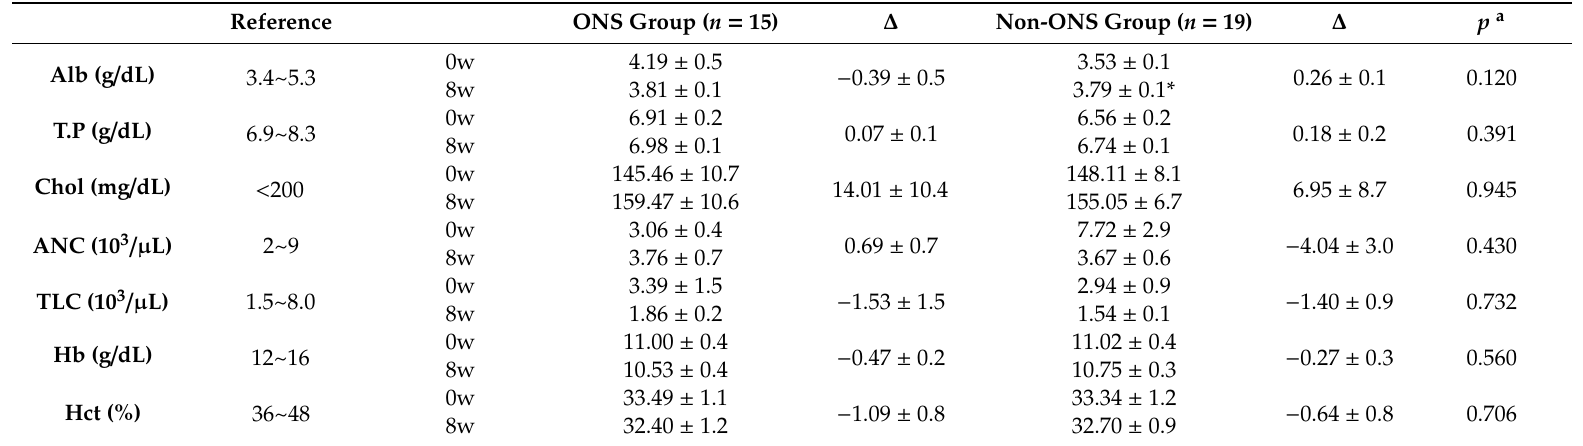
Table 4. Change of biochemical test between